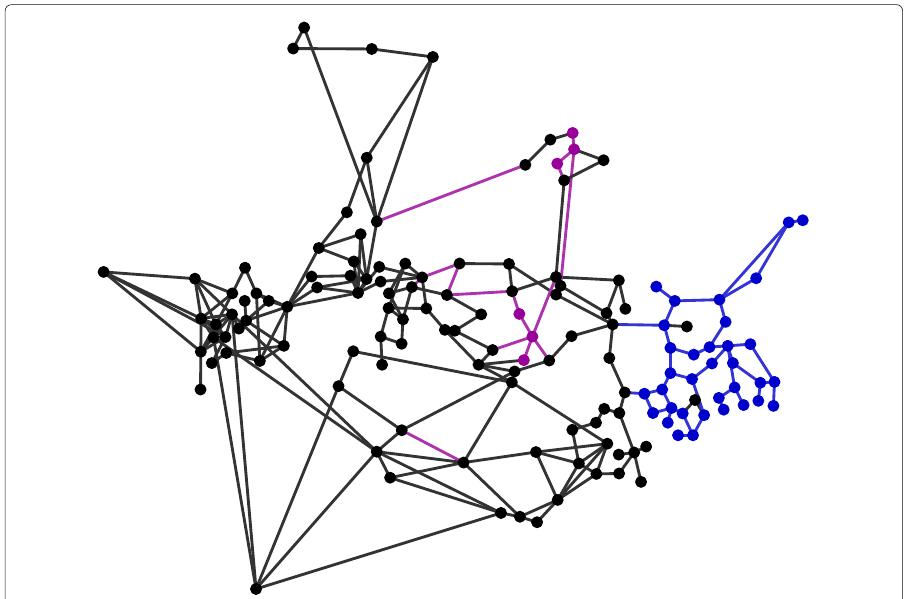
Fig. 5 Community Structure in CSI. Results of Adaptive BRIM community detection on the adjacency matrix of the bipartite instability graph. Small communities (containing fewer than 2 lines or buses) have been subsumed into neighboring